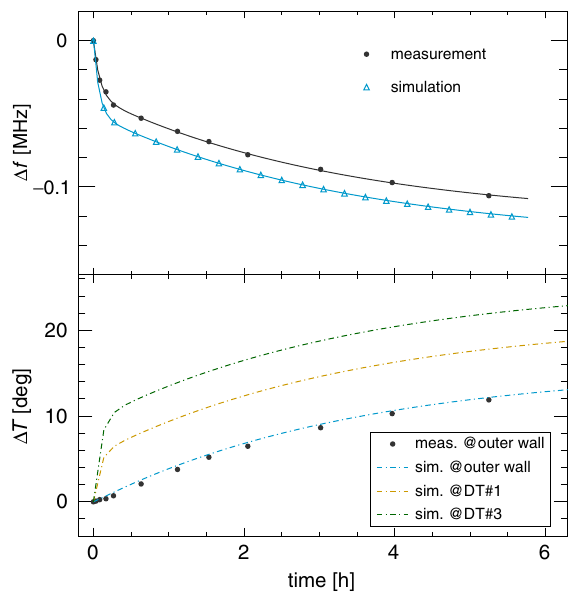
FIG. 16. Top: frequency shifts as functions of time after the rf power of 88 kW was turned on. The solid lines show the fitting results. Bottom: temperature drifts as functions of time. The data were plotted with the difference between ambient and cavity surface temperatures. The DT ’ s temperature was increased rapidly within 0.3 h in the